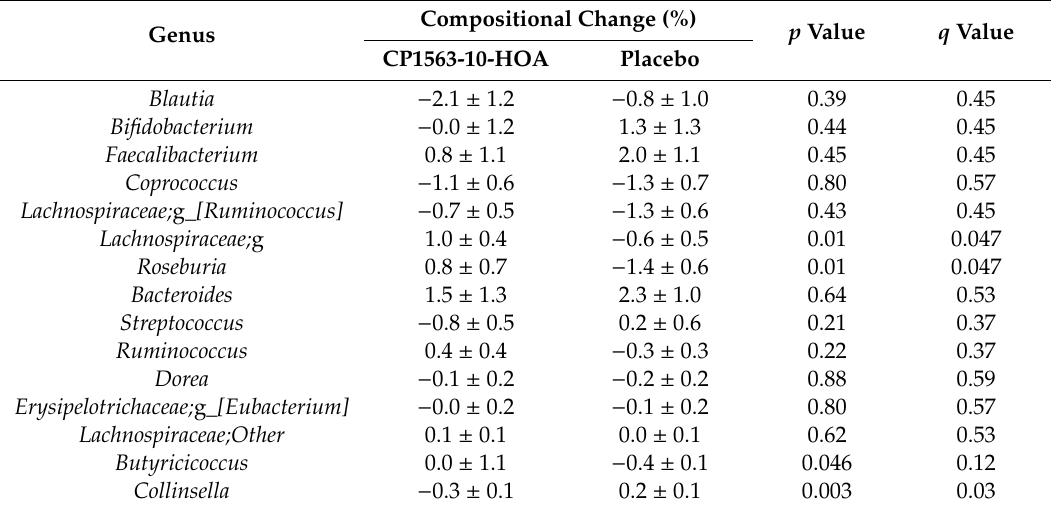
Table 3. Compositional change values of the fecal microbiota at the genus level. Genus